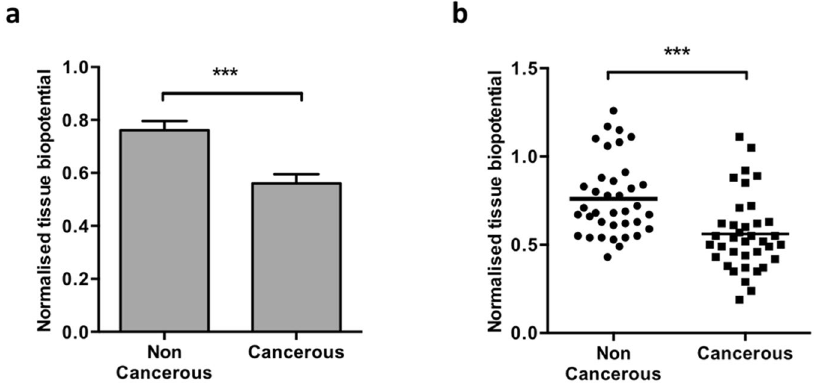
Figure 2. Biopotential levels differ between paired cancerous and non-cancerous tissues. ( a ) Biopotential data captured in the laboratory 45–120 min post removal on excised, paired omentum samples with macroscopically non-cancerous and cancerous appearance in different areas of the tissues. All biopotential readings were measured in triplicate and normalized to a reference media reading. Across the patient series, lower biopotential readings were observed for all cancerous samples compared to its paired non-cancerous counterpart (p < 0.001, n = 36). ( b ) A range of biopotential readings were collected across the patient series (each dot represents the mean of each tissue’s biopotential) for all tissues collected, consistently cancerous tissue had a lower biopotential than its non-cancerous pair (p < 0.001, n =